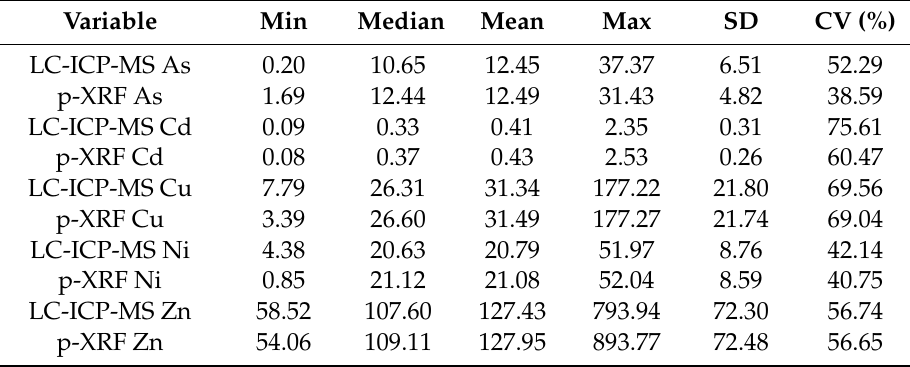
Table 1. Statistics of the potentially toxic elements (PTEs) content measured by LC-ICP-MS and p-XRF (mg / kg) ( n = 293). Variable Min Median